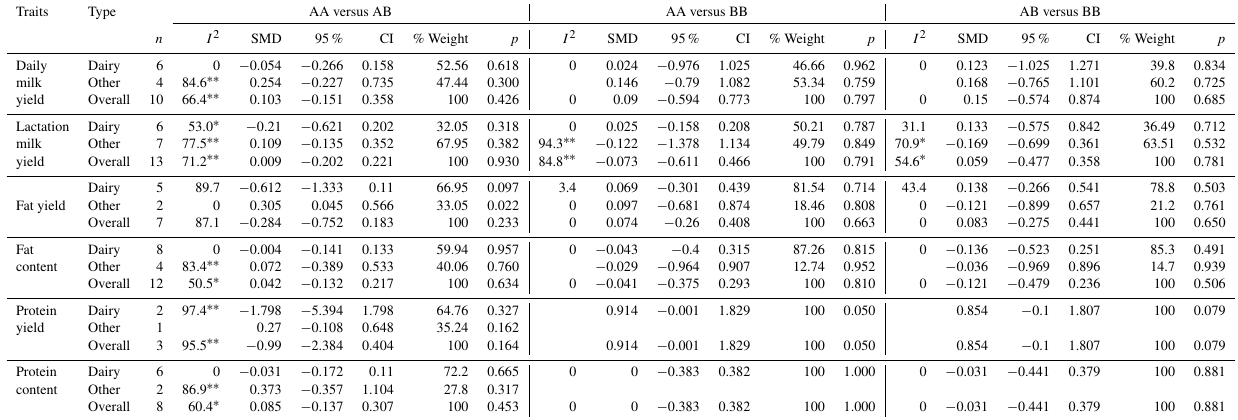
Table 4. Results of the meta-analysis on associations among CSN2 genotypes and milk production traits, SMD values, and level of signifi-